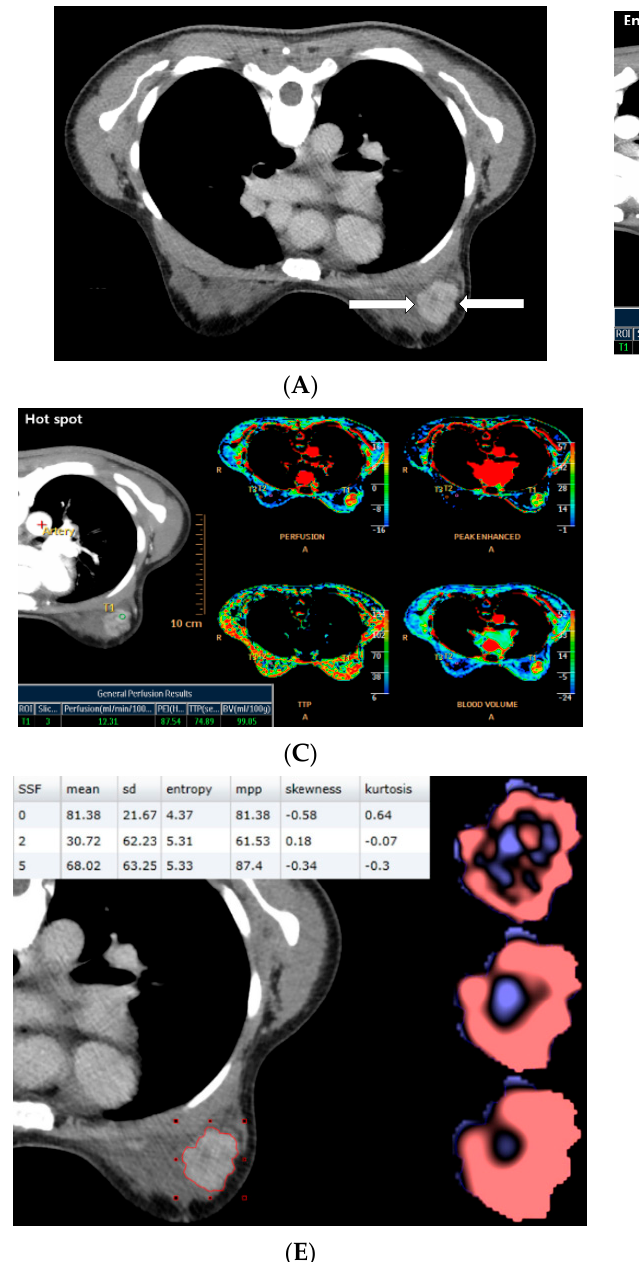
Figure 2. Perfusion and texture analyses on low-dose breast CT in a 47-year-old woman with invasive ductal cancer of the left breast. ( A ) Axial CT image shows an irregular shaped, irregular margined, heterogeneous enhancing mass (arrows). ( B , C ) Perfusion analysis was performed using the maximum slope algorithm. Regions of interest (ROIs) were drawn manually for the entire tumor extent ( B ) and hot spot ( C ) for each cancer and four perfusion parameters were measured at each ROI: perfusion, peak enhancement intensity (PEI), time to peak (TTP), and blood volume (BV). ( D , E ) Texture analysis was performed using a filtration histogram technique. The ROI was drawn manually for the entire tumor and a CT texture histogram was obtained ( D ). From the histogram, six statistical-based metrics were extracted ( E ). These six texture parameters were extracted from precontrast and postcontrast CT images for special scale filters (SSFs) 0, 2, and 5: mean, standard deviation (SD), entropy, mean of positive pixels (MPP), skewness, and kurtosis.